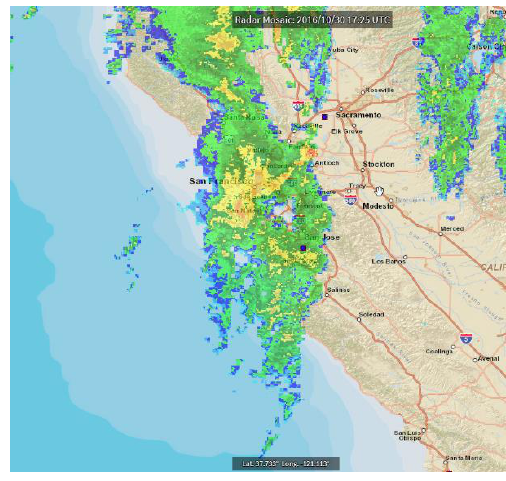
Figure 9. Composite radar for SFBA on 30 October 2016 at 1725Z.